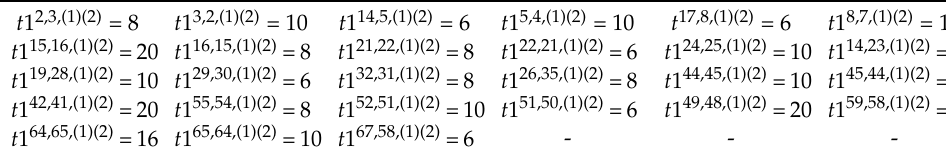
Table 6. Loading time [minutes].